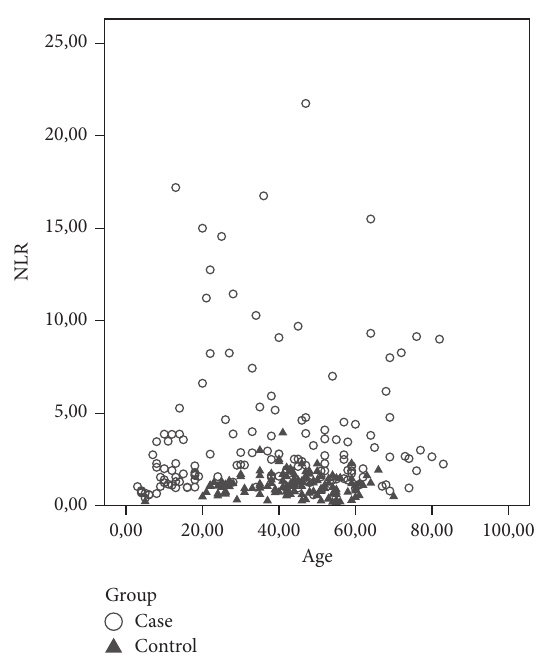
Figure 1: The distribution according to age of NLR in case and control groups.